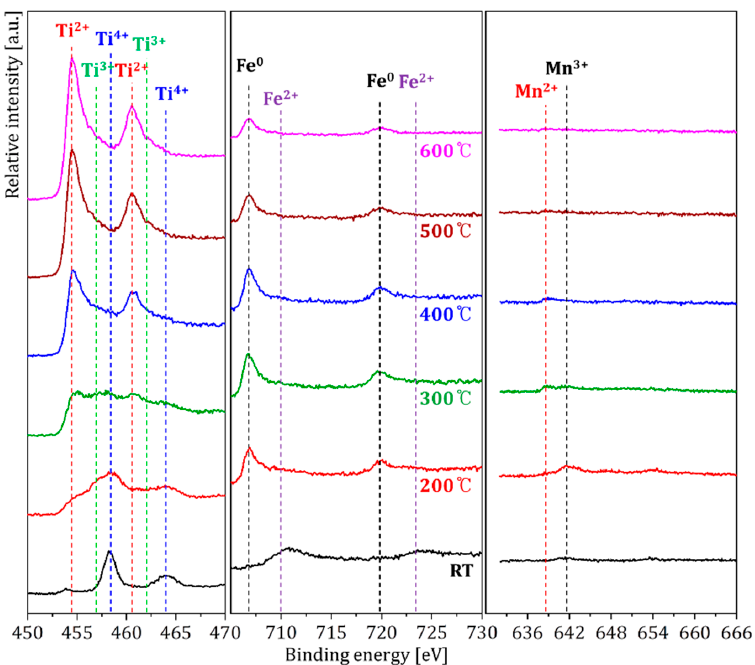
Figure 5. In situ heating X-ray photoelectron spectroscopy (XPS) of the TiFe 0.9 Ni 0.1 surface observed from room temperature (RT) to 600 °C.